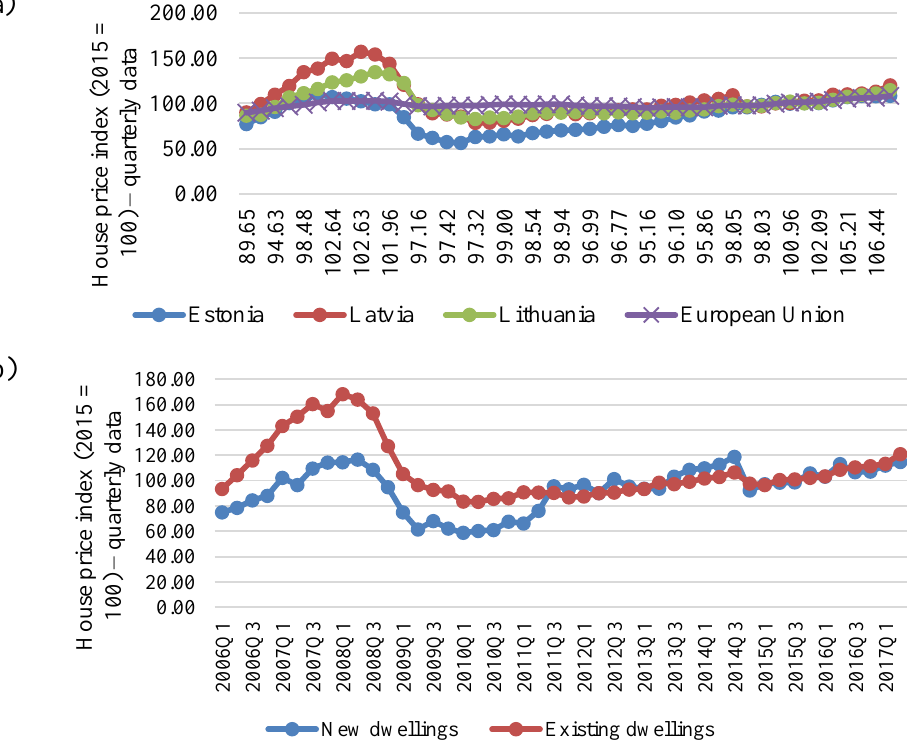
Fig. 2.a . Housing price index, 2015 = 100, quarterly data. Data: Eurostat (n.d.) Fig. 2.b. House price index for new and existing dwellings. Data: Eurostat (n.d.). (Figures made by